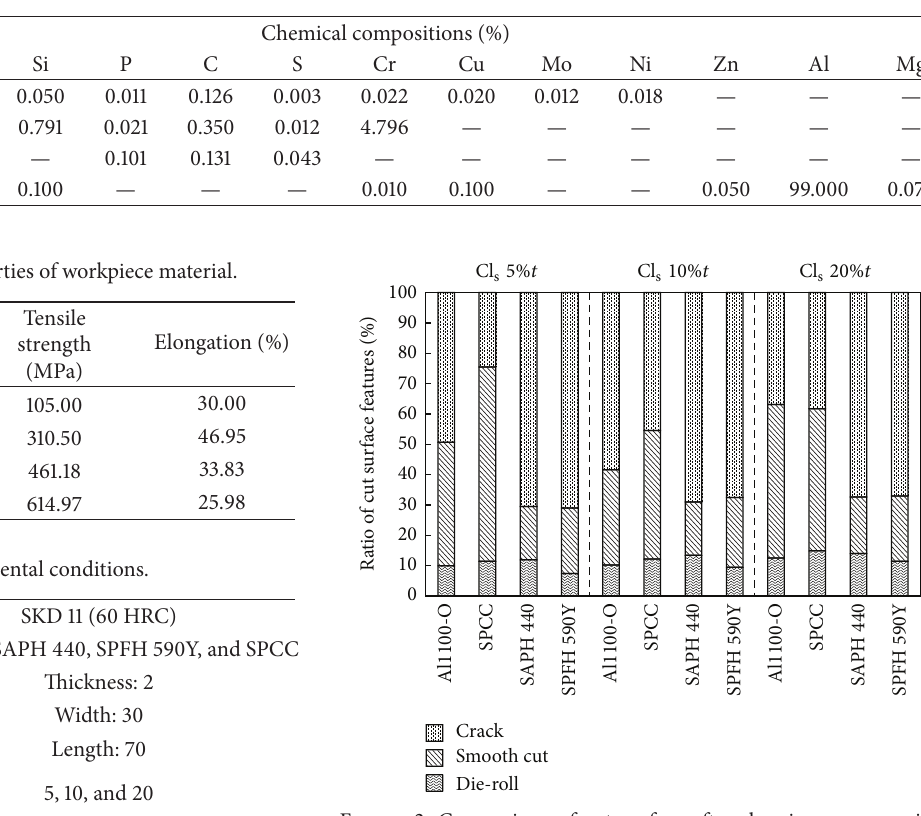
Table 1: Chemical composition of materials.